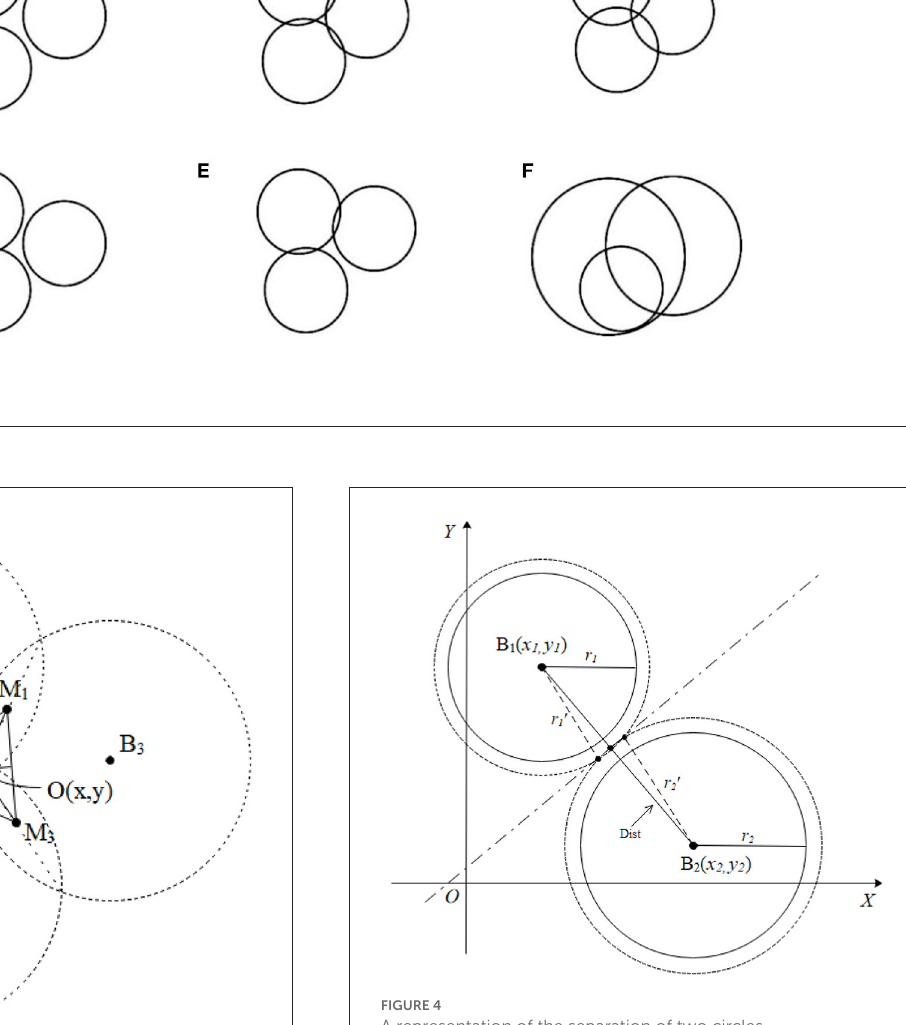
TOA algorithm error analysis